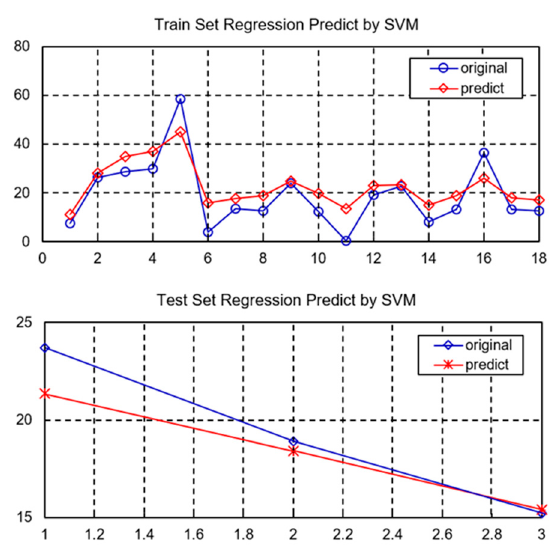
Figure 1. Predictive results of storm surge disasters loss based on support vector machine (SVM).